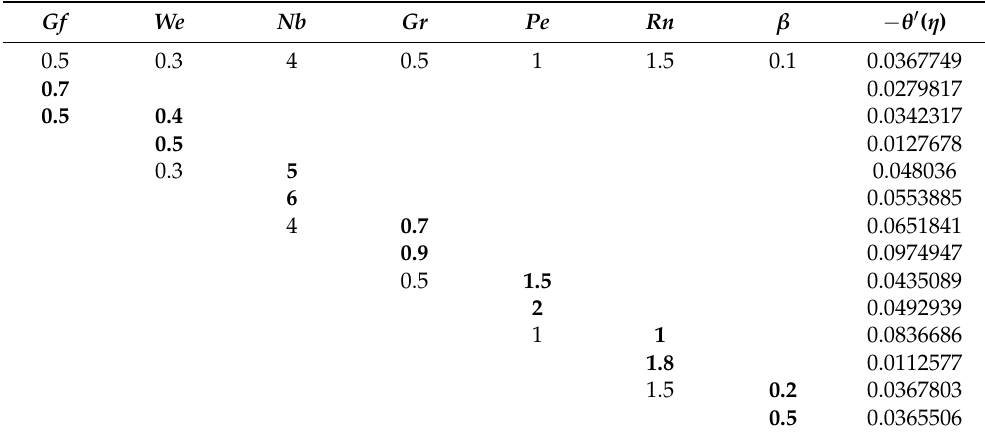
Table 2. Influences of distinct physical variables on − θ (cid:48) ( η